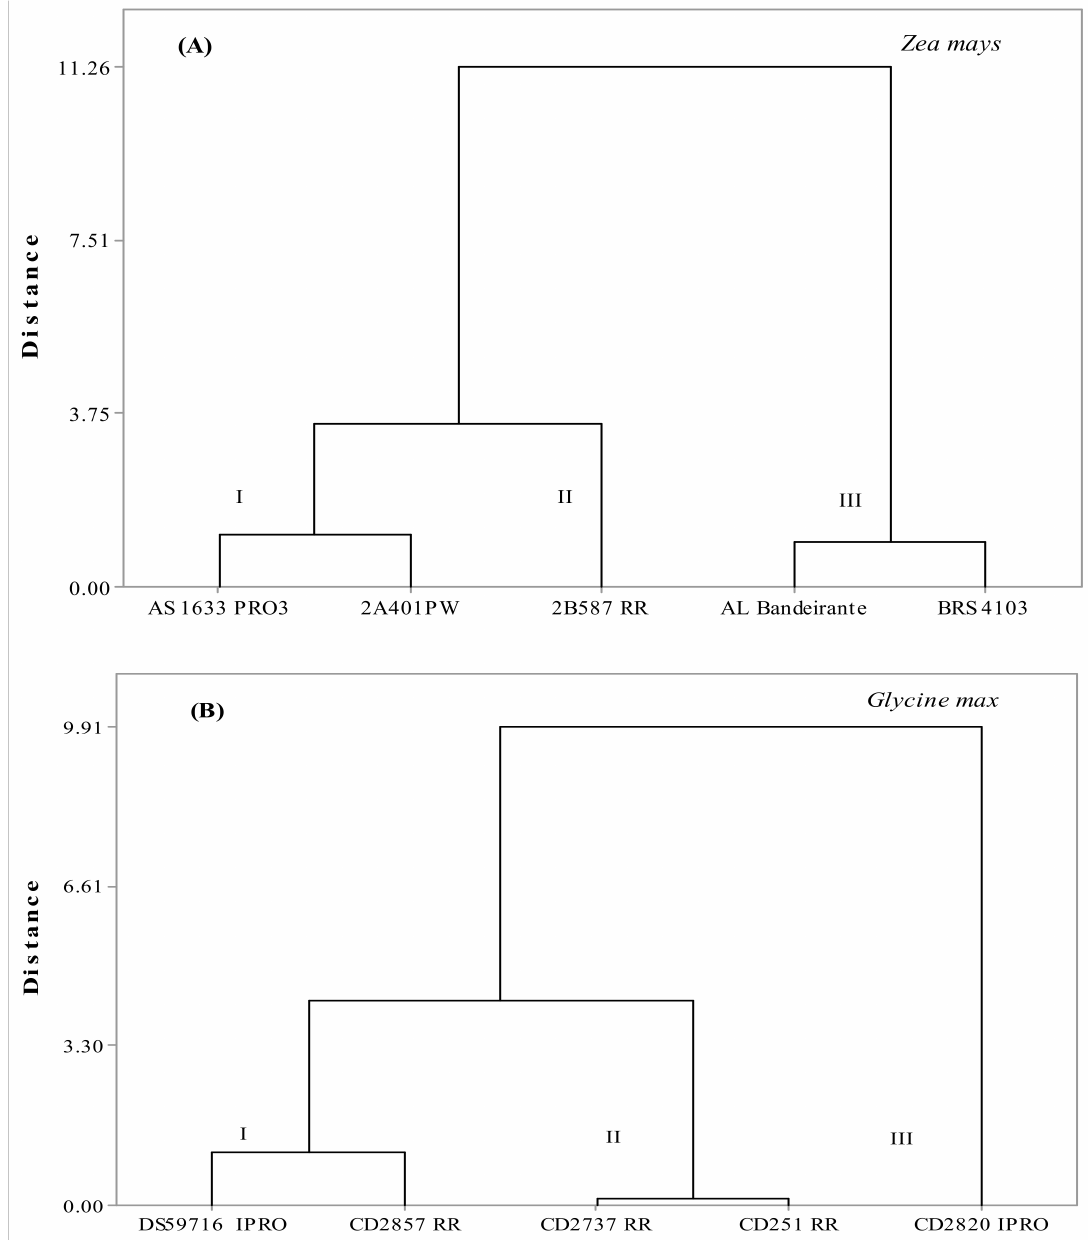
Figure 3. Dendrogram including germination and uniformity times for corn ( A ) and soybean ( B ) seeds. I, II and III = groups formed are after multivariate analysis by the Ward method using the Euclidean